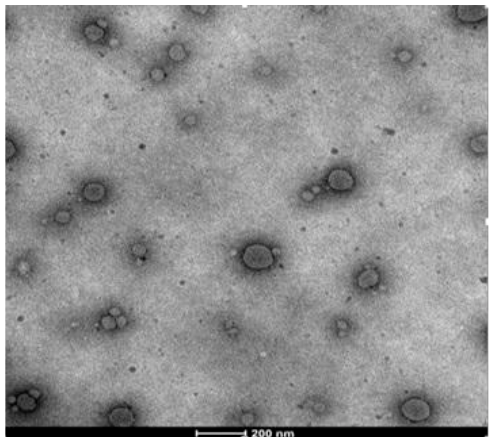
Figure 4. TEM image of nanoemulsion.